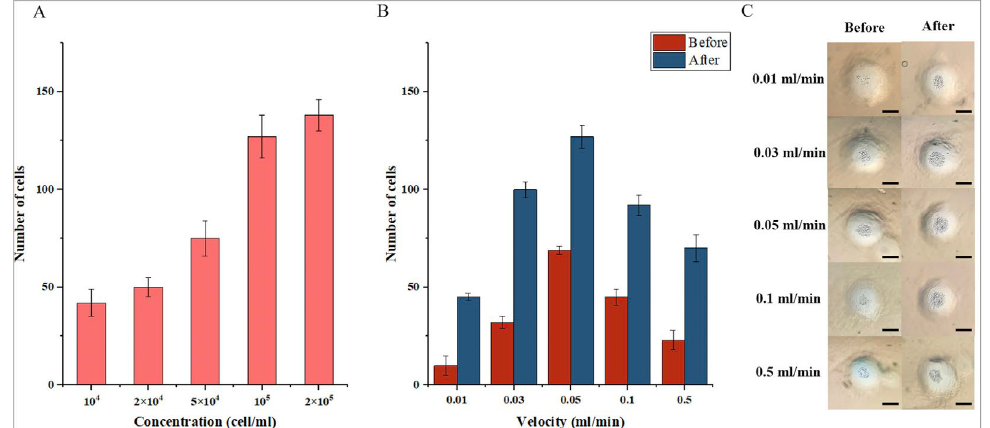
Figure 3. The effect of cell concentration and medium flow on cell seeding in the microfluidic device. ( A ) The number of cells seeding into the microwell increased in a cell concentration-dependent manner. ( B ) The number of cells seeding into the microwell decreased as the velocity increased from 0.1 mL/min to 0.5 mL/min. ( C ) The results are compared before and after washing and show that the excess cells on the microwell surface drifted down and increased the number of cells in the microwell (Scale bar = 150 µm, p < 0.05).